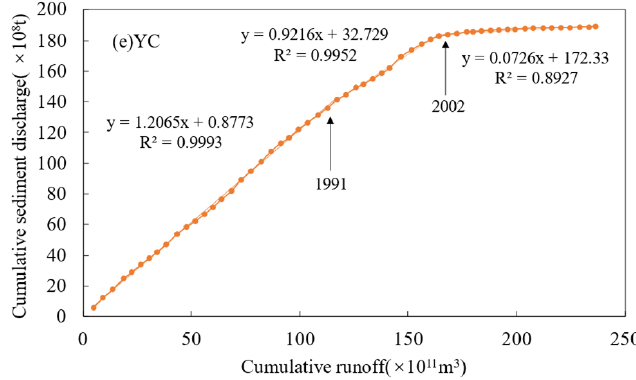
Figure 6. Runoff–sediment load double accumulation curve in the upper reaches of the Yangtze River.